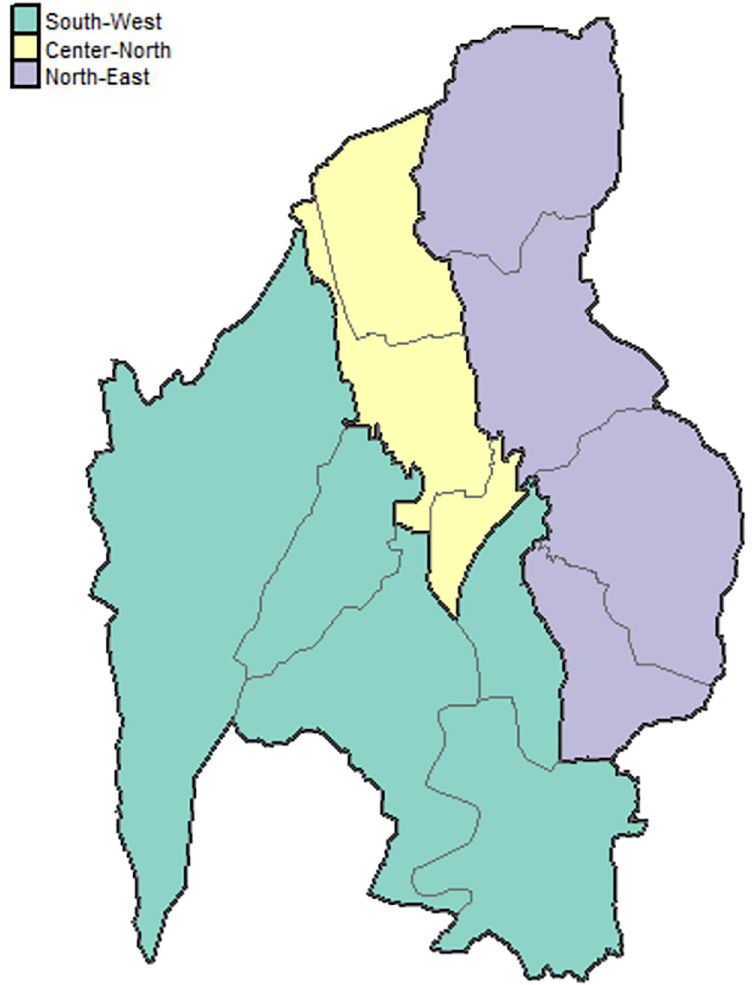
Fig 1. Map of the city of Trento (Italy). Black contours identify the 12 districts, and the three macro-areas are identified by three colors. The yellow area corresponds to the old town of the city, and it is the most populated